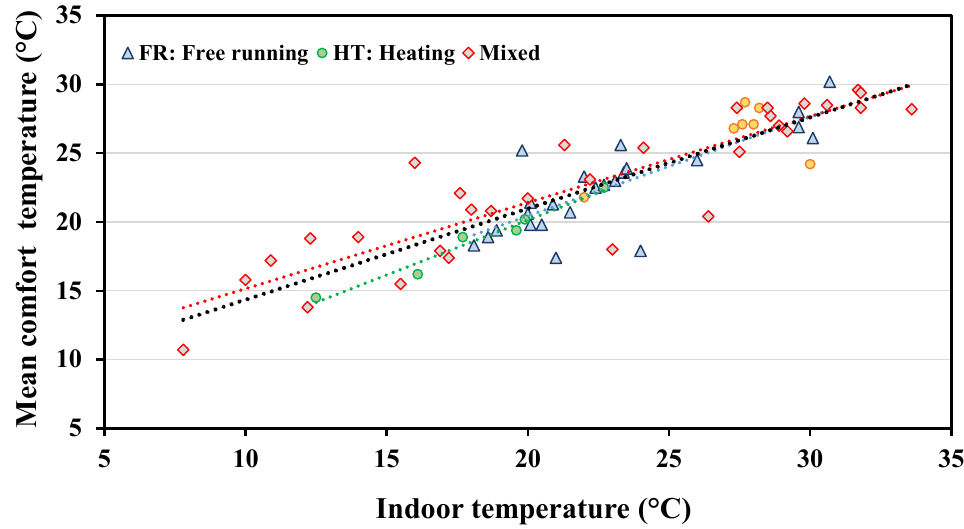
Figure 7. Correlation of mean comfort temperature with indoor temperature. Table 3. Regression equations from previous studies.